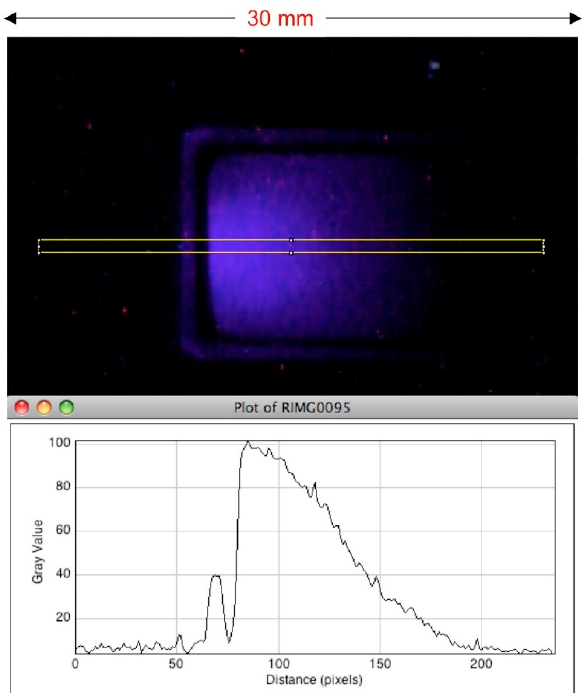
Figure 6. Upper : The depth-intensity image of the fluorescence of an RFG gel irradiated with a 3 mm diameter 3 MeV electron beam from a Van de Graaff accelerator. The yellow rectangle defines the limits of the plot-profile z-axis scan of the intensity shown in the lower part of the Figure. The pixel resolution was 0.11 mm per pixel. Taken from reference [26] Figure 9.